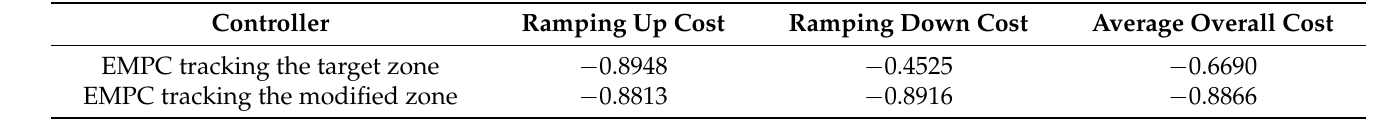
Figure 7. Trajectories of the stage cost for the absorption column under the operation of the zone EMPC control algorithm tracking the original target zone (blue) and modified zone (orange) for the time-varying flue gas flow rate. Table 6. Comparison of the average cost of NZEMPC and RZEMPC under time-varying flue gas flow rate (smaller is